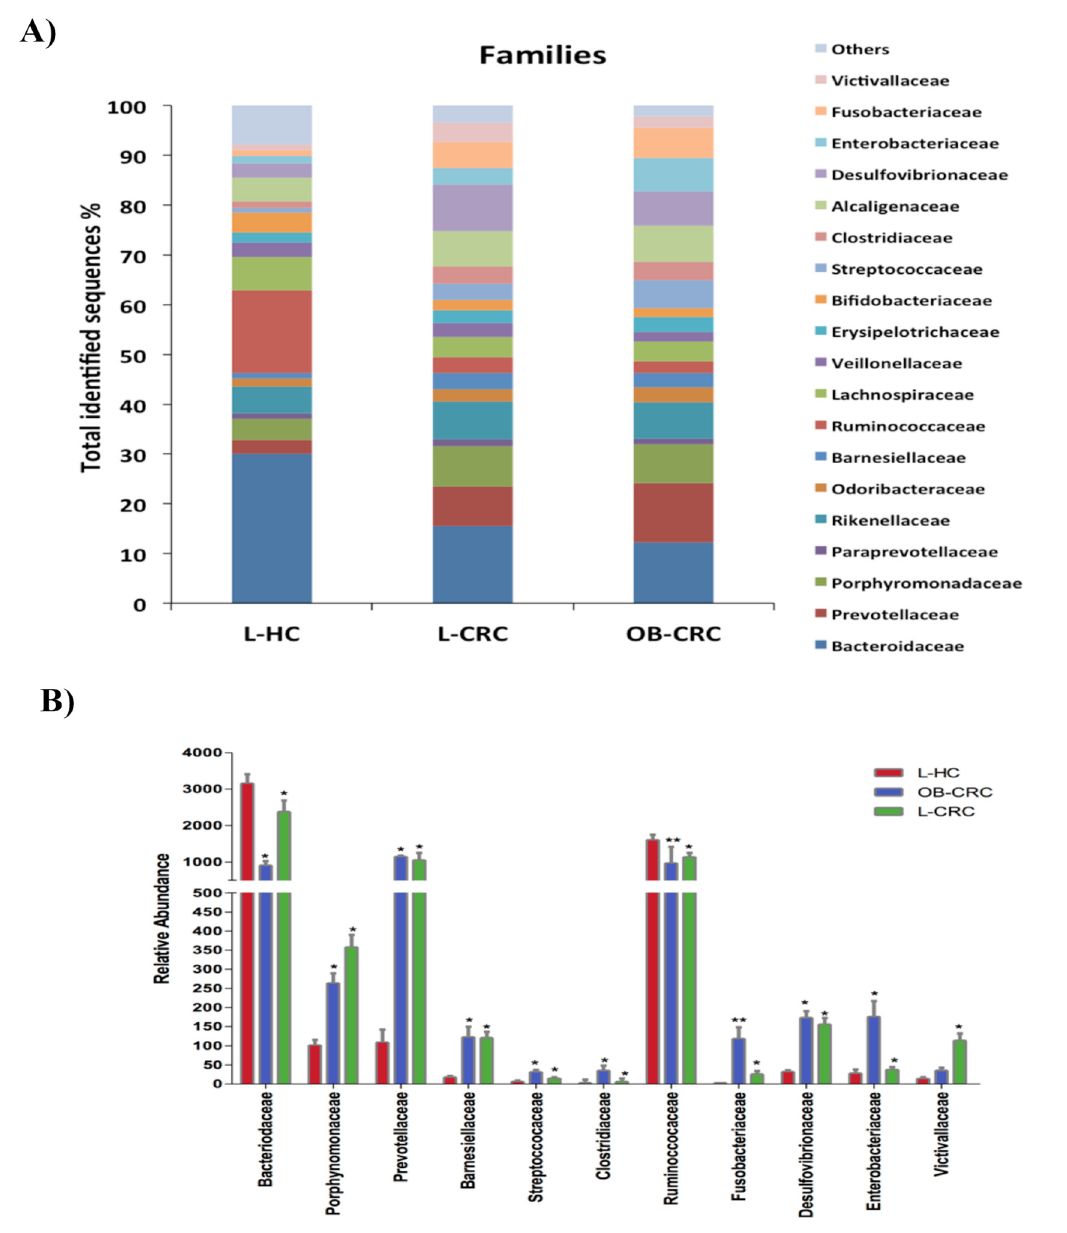
Figure 4. Family-level microbial classification of bacteria from OB-CRC, L-CRC, and L-HC stool samples. ( A ) Data are shown as a percentage of the total identified sequences per group. ( B ) Differentially abundant families in the stool samples of OB-CRC and L-CRC patients compared to L-HC * p < 0.05, ** p < 0.001. The bars indicate mean ± SD.